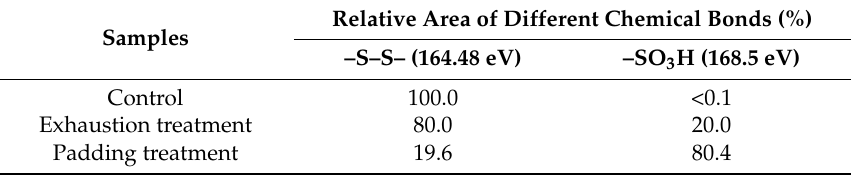
Table 4. Results of deconvolution analyses of S 2p peak for treated wool